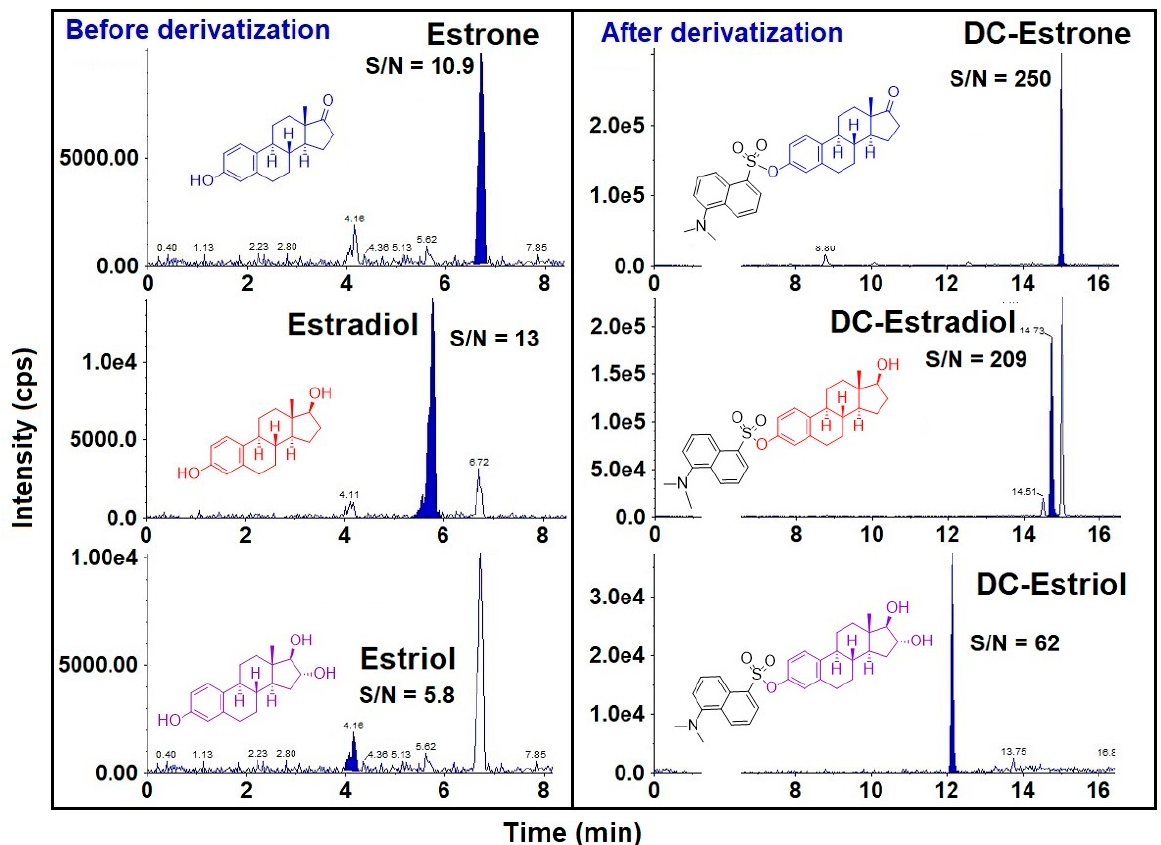
Figure 2. Comparison of LC-MS/MS responses of estrone, estradiol, and estriol before and after dansylation. Concentrations of the analytes were 1 ng/mL; Injection volume was 10 µL .